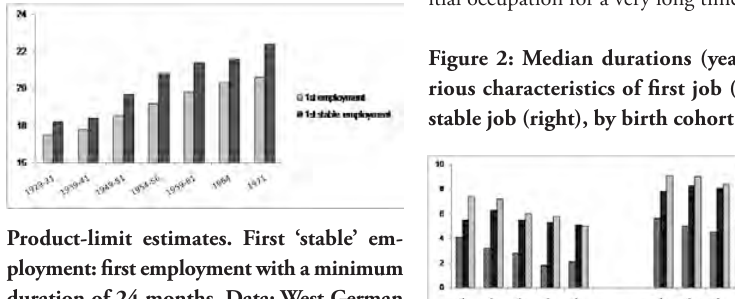
Product-limit estimates. Job: Median